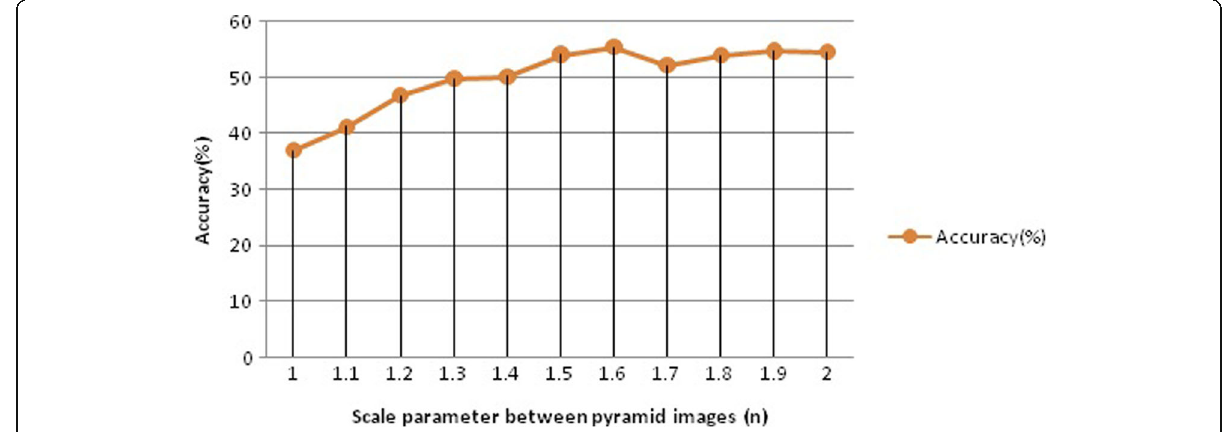
Fig. 6 Relationship between scale parameter variation and matching accuracy between pyramid